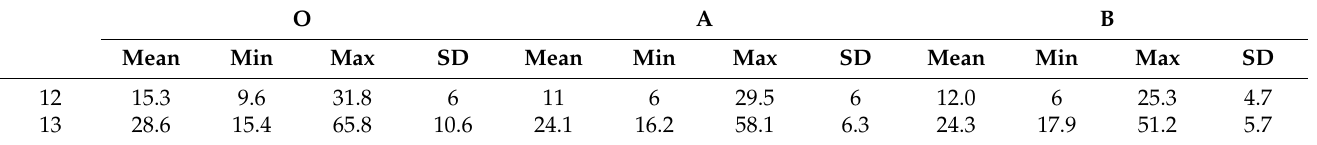
Table 6. Descriptive statistics of relative humidity at each test point on the 12th and 13th (%).